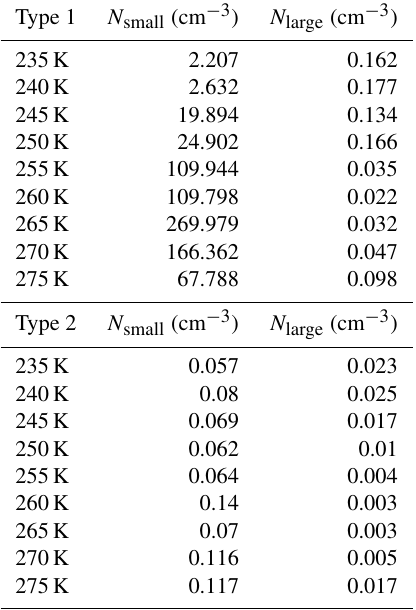
Table 6. Average cloud particle concentrations for the two cloud types defined in Sect. 3.1 (see also Fig. 5), for both small ( D p < 50µm) and large ( D p > 50µm) cloud particles.